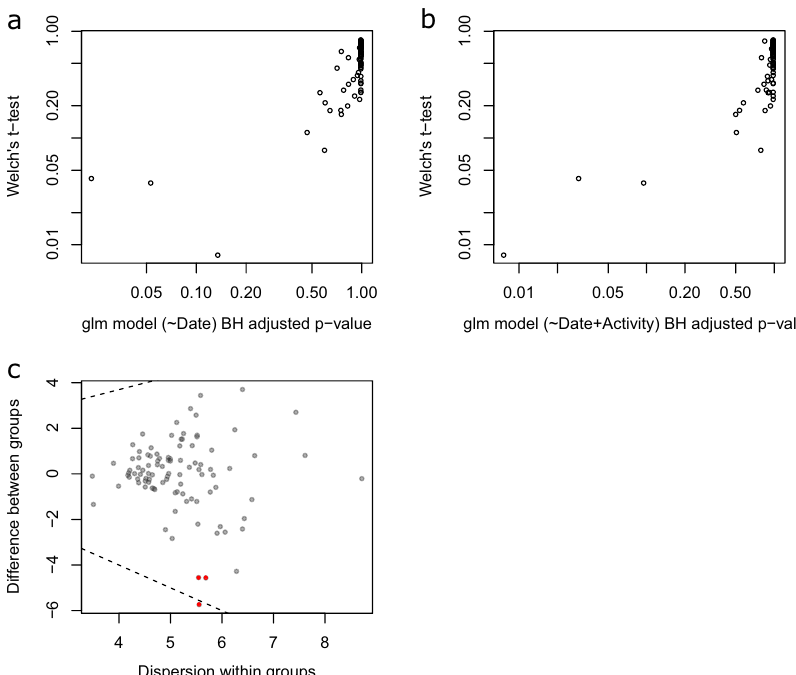
Fig. 3 Differential abundance analysis (ALDEx2) of rectal microbiota in healthy neonatal puppies on Days 1 and 8 post-partum. Comparing the glm and t -test. Plots of the expected P values for variables output from the glm function with model. a Day postpartum as a fi xed predictor and model; b with activity scale as a random effect predictor compared to the P values output by the Welch ’ s t -test. All values are the expected value of the test statistic after correction for multiple hypothesis testing; c effect size plot indicating between group difference ( Y axis) and within group dispersion ( X axis). Red represents features called as differentially abundant with p.adj < 0.1. Puppy ID was included as a random factor in all models. See Supplementary Table 2 for taxa